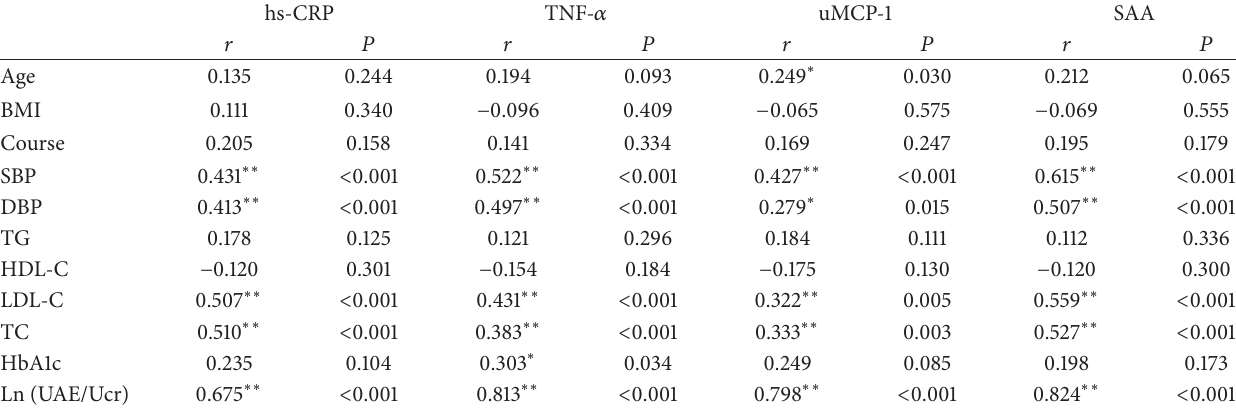
Table 2: Correlation analysis of inflammation cytokines and various